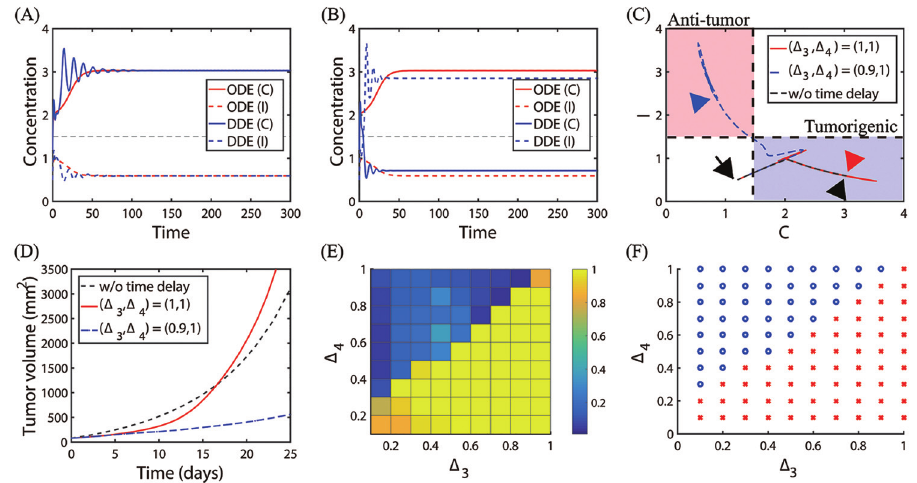
Fig 18. Dynamics of the system with time delays ( Δ 3 , Δ 4 ) in apoptosis of TANs. (A, B) Time courses of concentrations of two main variables ( C , I ) in the absence (ODE, red) and presence (DDE, blue) of time delays: Δ 3 = 1, Δ 4 = 1 in (A); Δ 3 = 0.9, Δ 4 = 1.0 in (B). (C) Trajectories of solutions ( C ( t ), I ( t )) without (black dotted) and with (( Δ 3 , Δ 4 ) = (1, 1) red solid; ( Δ 3 , Δ 4 ) = (0.9, 1) blue dashed) time delays in (A-B). (D) Time courses of the tumor volumes corresponding to (C). (E) Normalized tumor sizes for various strengths of the two time delays ( Δ 3 and Δ 4 ). (F) Risk map of the time delay-induced transition of TANs from N2 to N1 phenotypes in the Δ 3 − Δ 4 plane. Blue circle = switching to the N1-dominant system. Red asterisk = persisting N2-dominant mode. Parameters: S = 0.2, G = 0.4. All other parameters are fixed as in Table 2. Initial condition: T (0) = 0.2, C (0) = 1.2, I (0) = 0.5. position was marked in black arrow. While the presence of time delays ( Δ , Δ ) = (1, 1) induces 3 4 initial fluctuations (Fig 18A), the solutions converge to the N2-dominant steady states of ODEs (red arrowhead in Fig 18C). However, a slightly different combination of time delays (( Δ , Δ ) = (0.9, 1)) leads to a phenotypic transition from the N2-dominant mode to the 3 4 N1-dominant phase (blue arrowhead in Fig 18C) despite the initial fluctuation of solutions (blue curves in Fig 18B). Delayed apoptotic cell death leads to different tumor growth dynam- ics. Fig 18D shows time courses of the tumor volumes corresponding to three cases in Fig 18C. In the presence of time delays ( Δ , Δ ) = (1, 1), the tumor grows slower than the control (case 3 4 without time delays) initially but the delay-induced oscillations push the TAN system to the N2-dominant phenotype faster than the control case around t = 18 days , leading to the larger N2-to-N1 ratio and faster tumor growth (red curve in Fig 18D). On the other hand, in the presence of time delays ( Δ , Δ ) = (0.9, 1), the tumor grows slower than the control due to 3 4 strong suppression of the N2 module and enhancement of the N1 module. Fig 18E shows the normalized tumor size at t = 25 days for various strengths of the two time delays ( Δ , Δ 2 3 4 [0, 1]) with a uniform length of 0.1. A risk map of time delay-induced transition of TANs from N2 to N1 phenotypes in the Δ plane is shown in Fig 18F. For a fixed value of Δ , an Δ 3 − 4 3 increase in Δ results in the higher chance of transition to the P -phase, thus slower tumor 4 a growth. On the other hand, for a fixed value of Δ , an increase in Δ leads to a higher probabil- 4 3 ity of transition to the P -phase and faster tumor growth. To characterize the complex dynam- t ics of the apoptotic cell death mechanism, we introduce the following Δ -to- Δ ratio: 4 3 time delay in apoptosis of N1 TANs ¼ : time delay in apoptosis of N2 TANs When D is large, the delayed apoptotic process of N1 phenotypes and minimal delay in the ap apoptotic process of N2 phenotypes allow accumulation of more N1 TANs within the